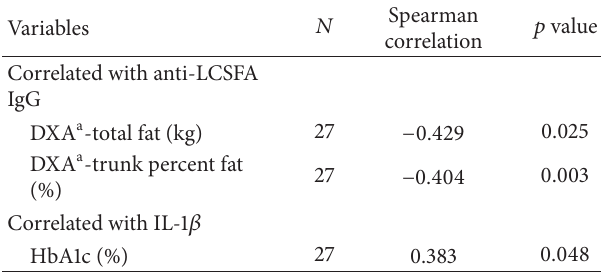
Table 5: Anti-LCSFA antibodies and IL-1 𝛽 from serum of Hispanics with type 2 diabetes correlate with body composition and HbA1c,